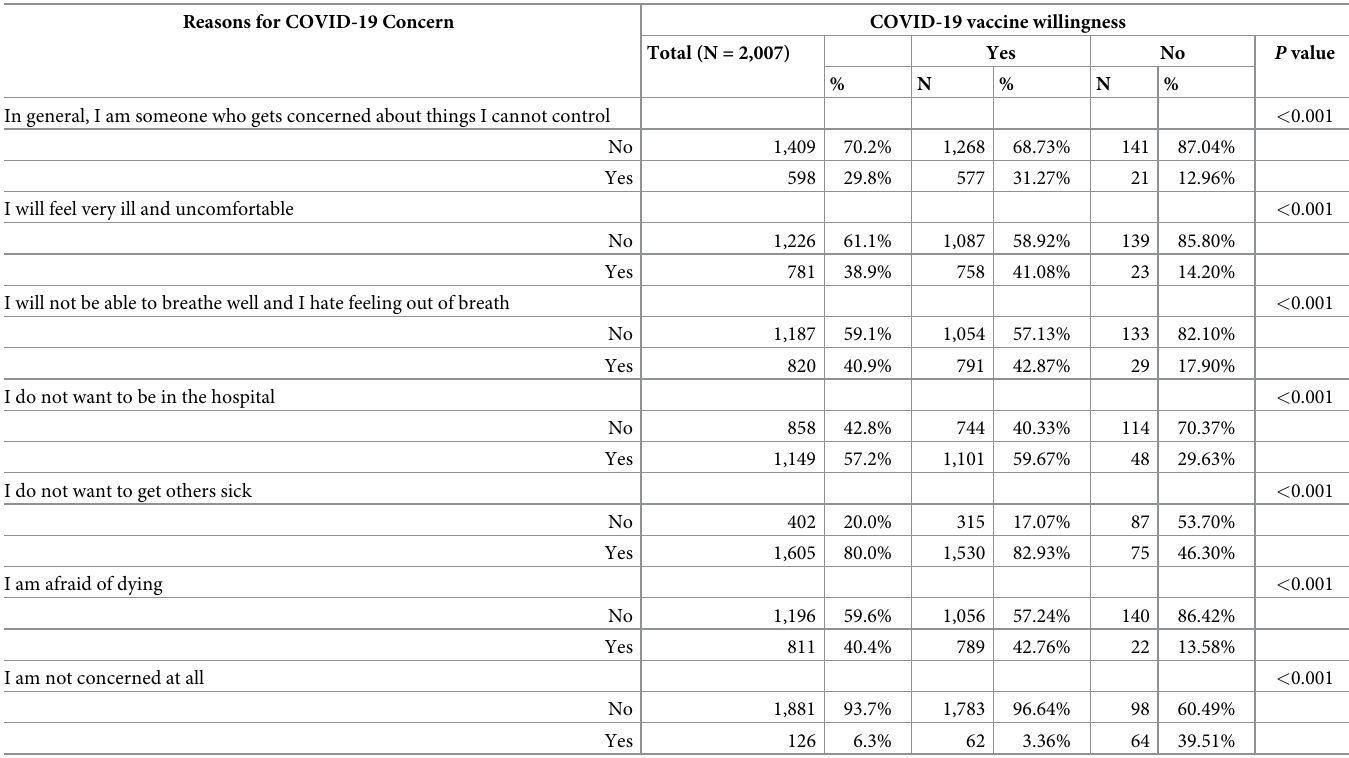
Table 2. Reasons for COVID-19